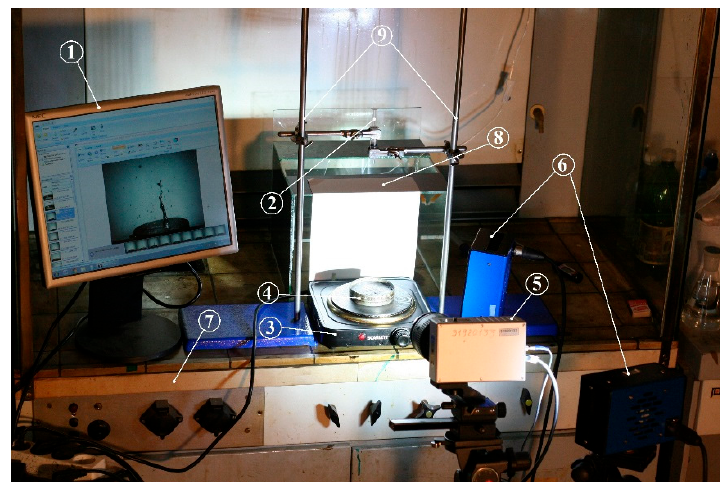
Figure 1. Experimental facility: 1—computer, 2—injector, 3—heater, 4—reservoir, 5—camera Optronis CR3000x2, 6—light sources, 7—fume hood, 8—screens, 9—tripods. Table 1. Properties of Rose’s alloy [26,27].